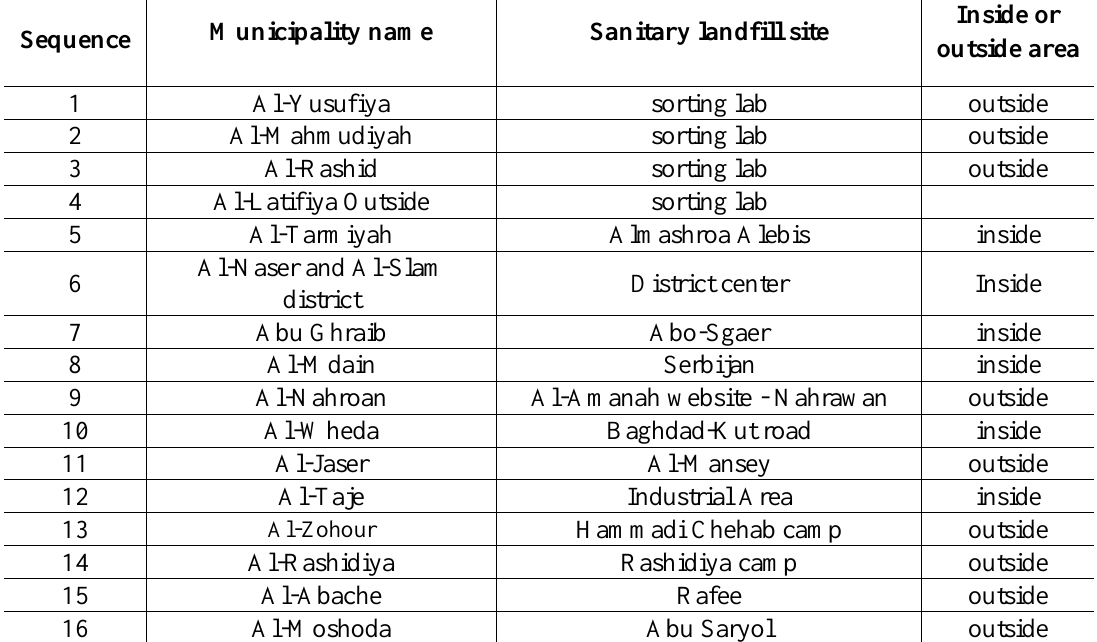
Table 1: Location of